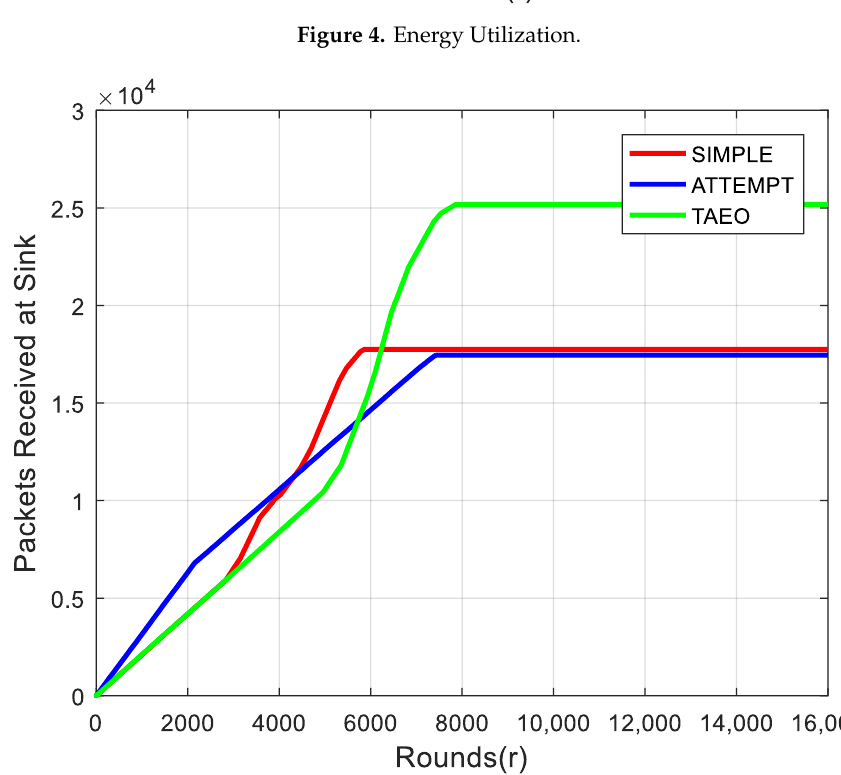
Sensors 2019 , 19 , x FOR PEER REVIEW